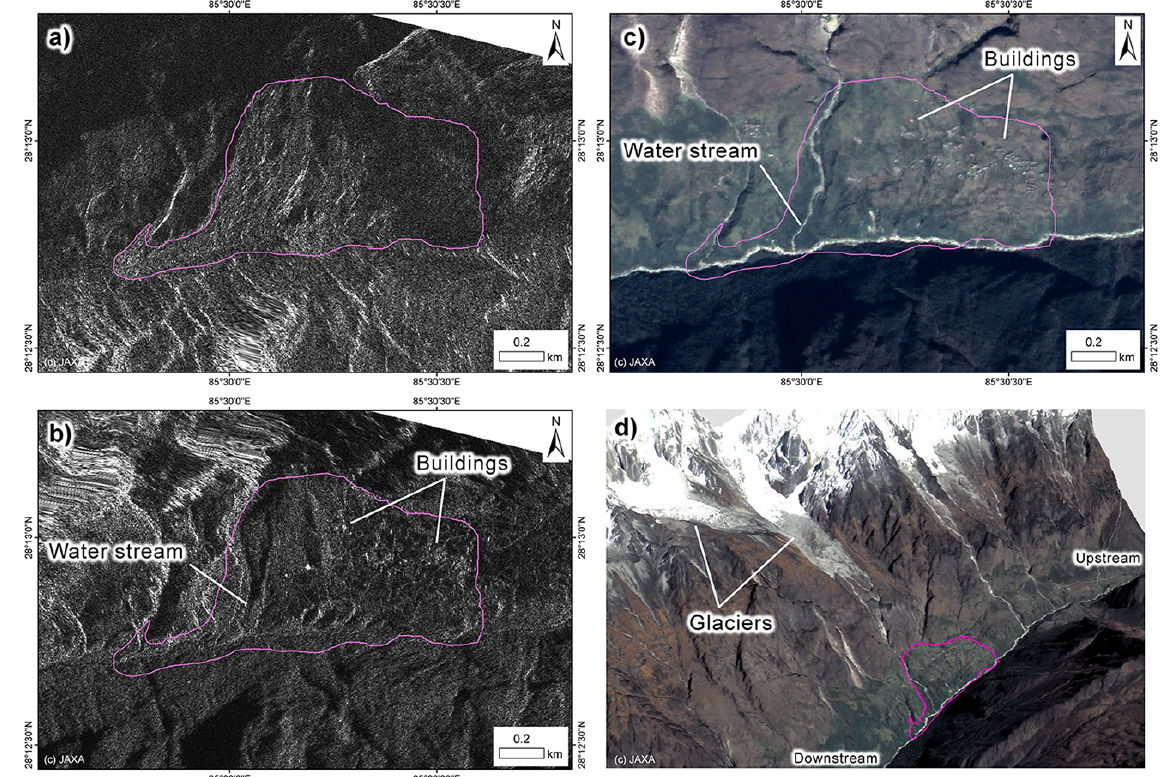
Figure 5. Collapsed sediment identified on ALOS/ALOS-2 images. Difference between PALSAR-2 images of (a) post-quake (26 April 2015) and (b) pre-quake (28 December 2014) denotes that the buildings and water stream identifiable by (c) a pre-quake ALOS pan-sharpened image (12 October 2008) were covered by sediments. (d) A three-dimensional view of the ALOS pan-sharpened image overlaid on ALOS World 3D digital surface